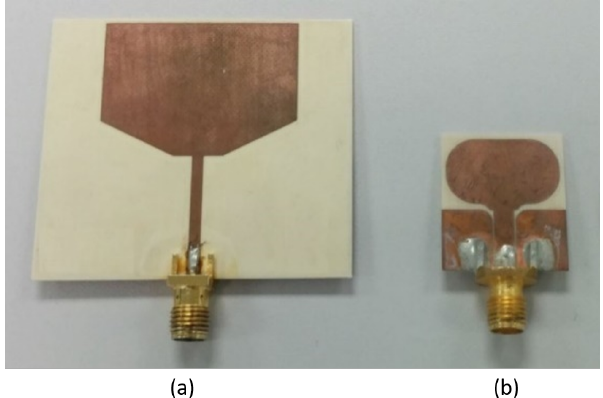
Figure 7. UWB antennas ( a ) Eve Antenna ( b ) Transmitter and Legitimate receiver.